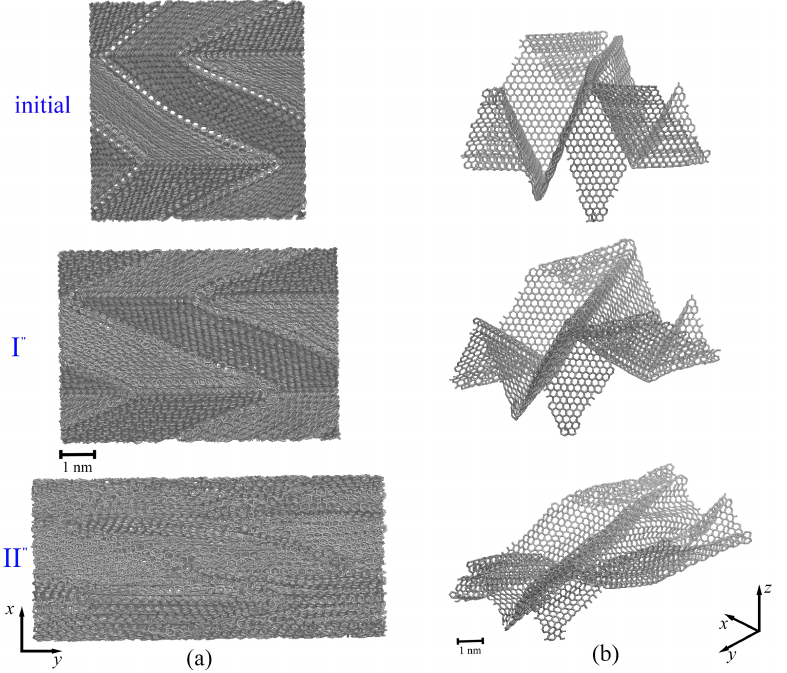
Figure 5. The snapshots of the MG in projection to ( a ) the xy -plane and ( b ) snapshot of the graphene layer in perspective view at the initial state and during tension along the y -axis at critical points I” ( ε = 0.3) and II” ( ε = 0.6). The structure after compression and before tension is labeled as “initial”. Points I” and II” are shown as a blue solid line in Figure3. The tension direction is shown by black